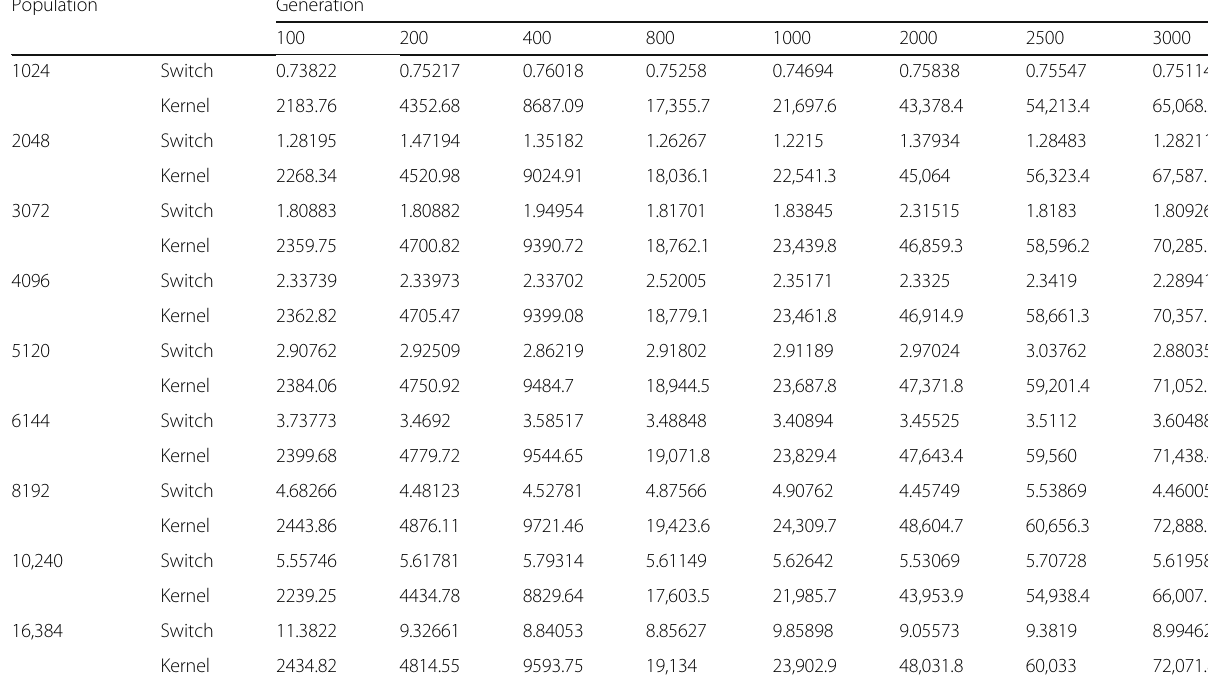
Table 1 Switching and kernel computation time (ms) in CUDA- 380 cities (BCL380)